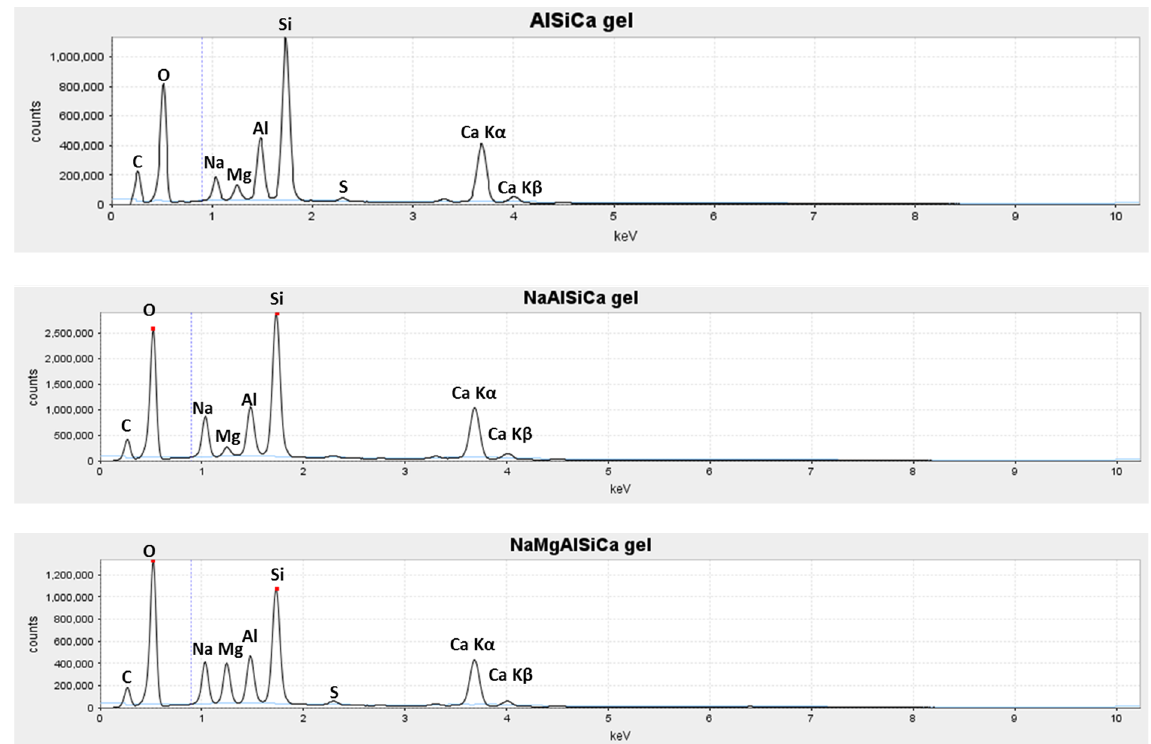
Figure 19. PARC sum spectrum from compound domain of CaAlSi gel, CaNaAlSi gel, and CaMgNaAlSi gel in S50.